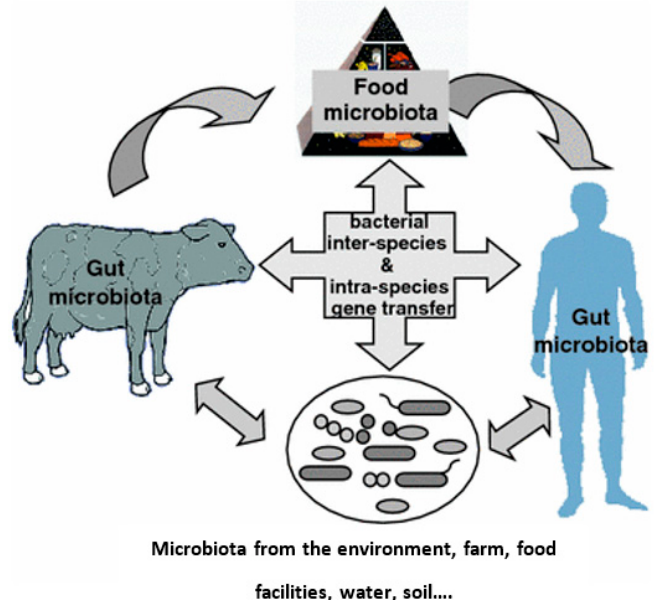
Figure 2. Graphic representation of transmission routes of resistant bacteria and resistance genes, which include animals, farms, food production facilities, food, and consumers (adapted from [112]).